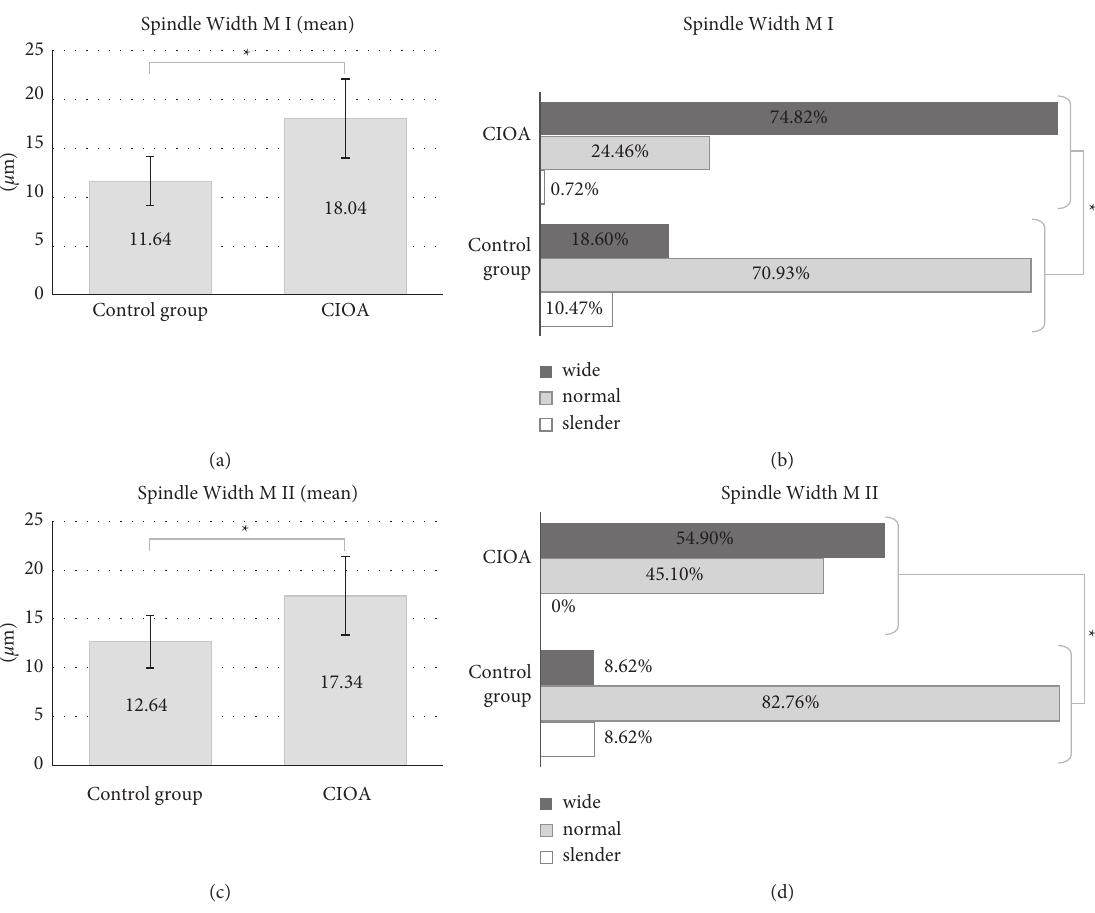
Figure 2: Meiotic spindle width. (a, b) Data for M I and (c, d) data for M II. (a) M I mean spindle width (total mean ± 1 SD), comparison of controls (11.64 ± 2.51 μ m, n � 86) and CIOA (18.04 ± 4.05 μ m, n � 116); independent samples t -test, ∗ p < 0 . 001. (b) Distribution of M I spindle width category frequencies in %. “Normal” range (mean ± 1 SD) from the control group. Control group ( n � 86): slender ( n � 9), normal (11.64 ± 2.51 μ m, n � 67), and wide ( n � 10); CIOA ( n � 139): slender ( n � 1), normal (11.64 ± 2.51 μ m, n � 43), and wide ( n �